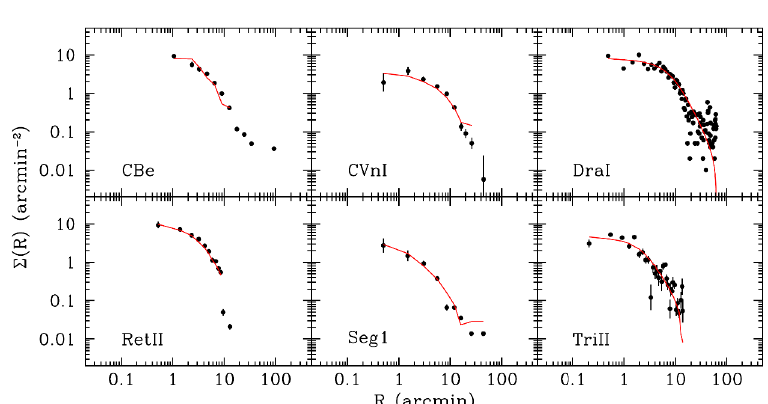
Figure 1: Best-fit brightness profiles Σ ( R ) of the analyzed dSphs as a function of the object’s projected (2D) radial coordinate R from the dSph centroid. In each panel, the projected 3D profile resulting from the fit ( red line ) is shown superimposed to the corresponding data set ( black dots ;